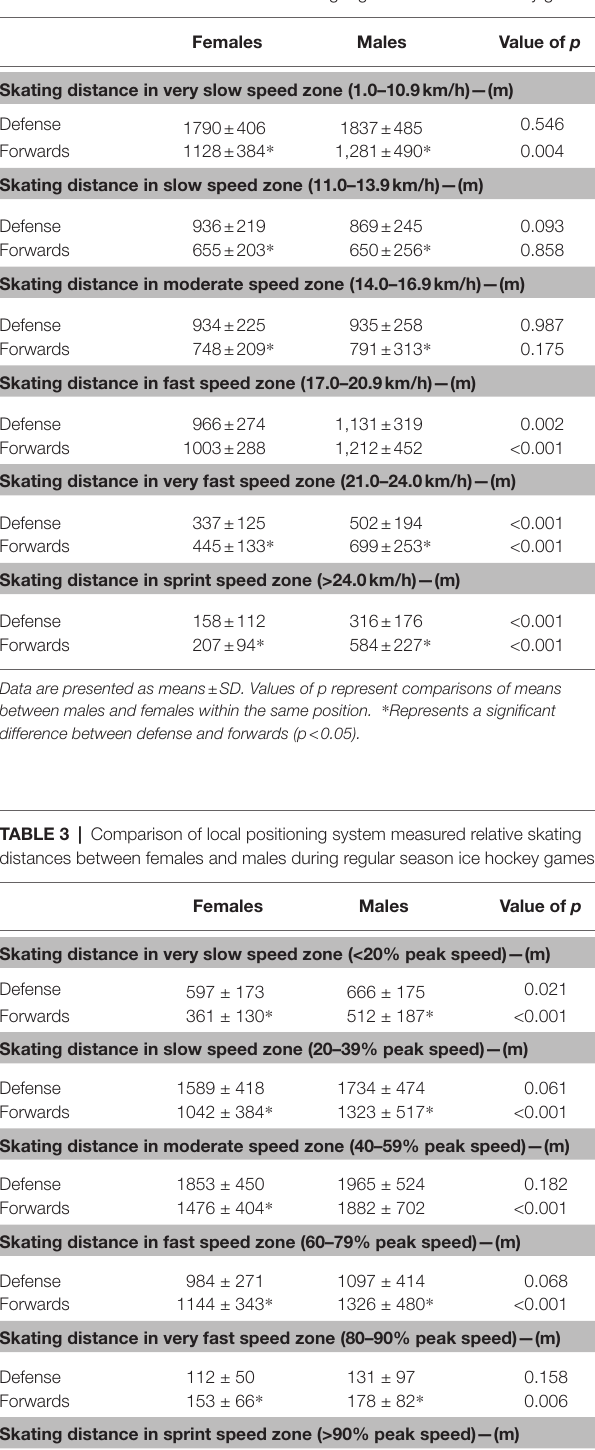
TABLE 4 | Comparison of local positioning system-derived external load between females and males during regular season ice hockey games. Females